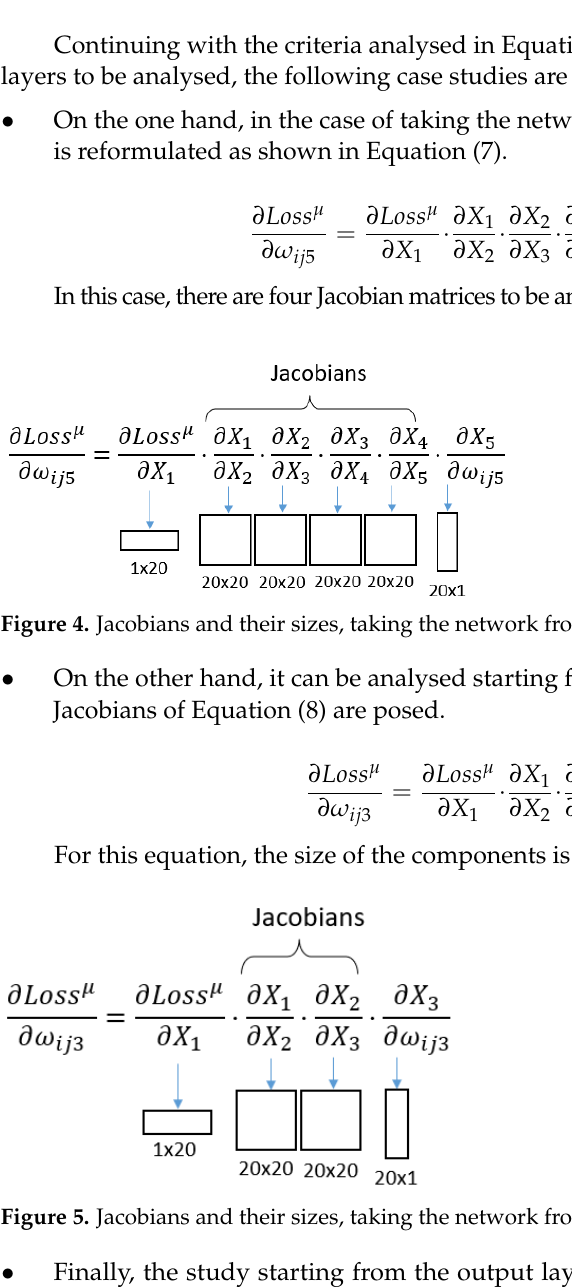
Figure 3. Representation of the network under study.